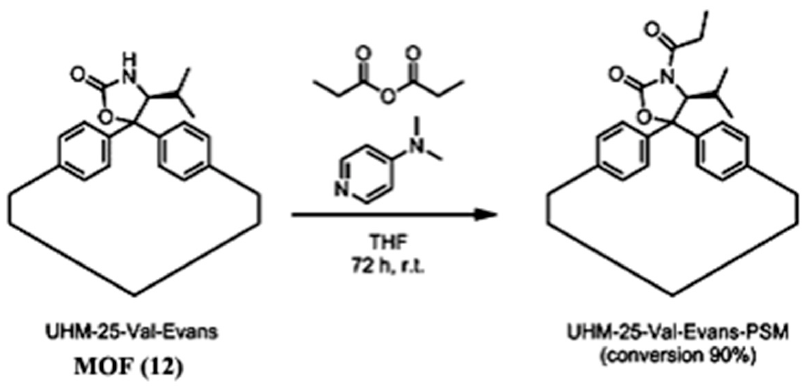
Figure 6. Post-synthetic acylation of UHM-25-Val-Evans ( 12 ). Reproduced from [47] with permission from the American Chemical Society. r.t.: room temperature.